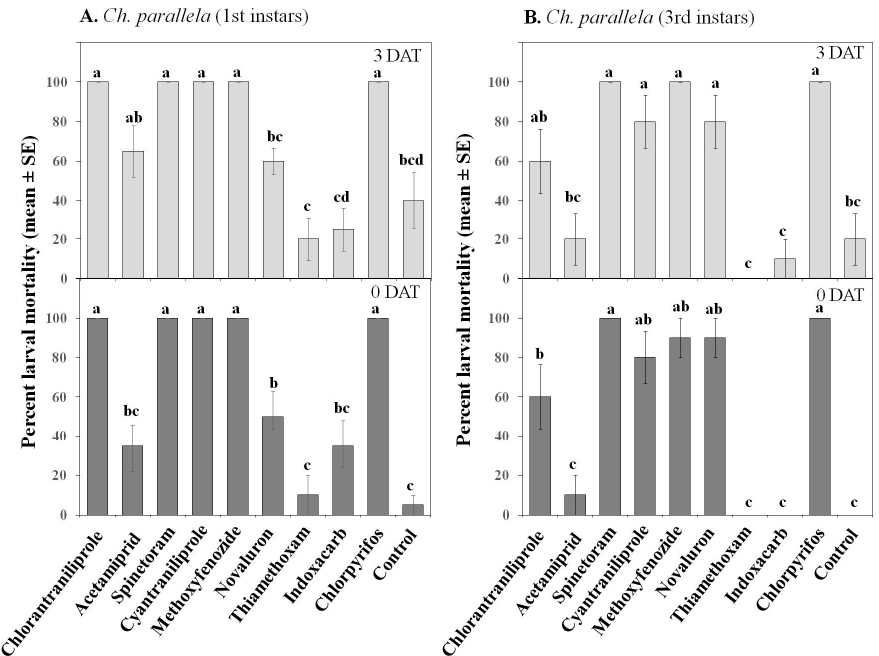
Figure 3. Effect of various insecticides on Choristoneura parallela 1st ( A ) and 3rd ( B ) instar larvae after exposure to 2 h (0 DAT) and 3 DAT laboratory-aged residues. DAT = days after treatment. Bars with the same letter are not significantly different at α = 0.05.